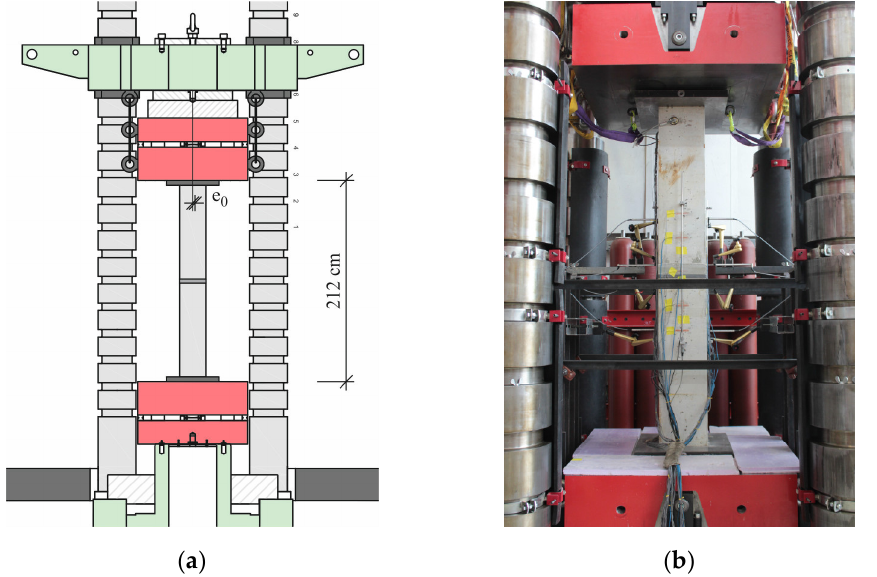
Figure 4. Experimental setup: ( a ) schematic draft of 30 MN testing machine with butt-jointed column; ( b ) installed large-scale test S 9.3 before testing.